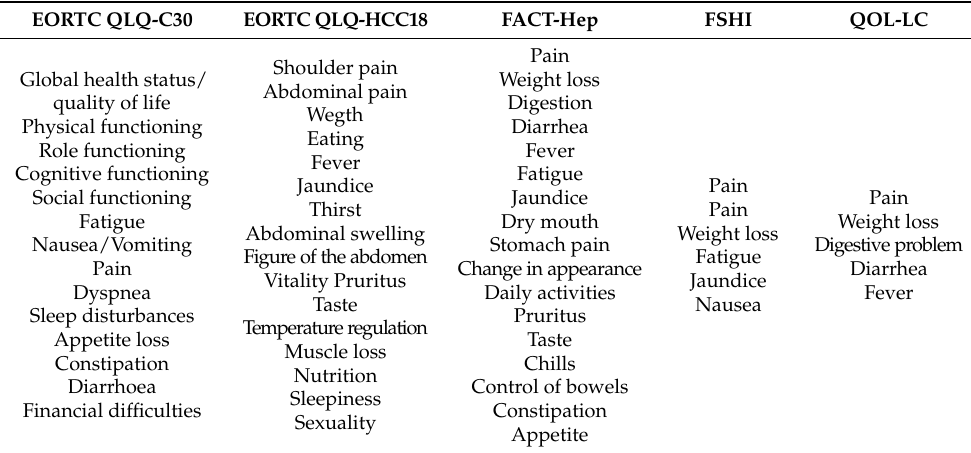
Table 1. QoL scales and symptoms assessed.